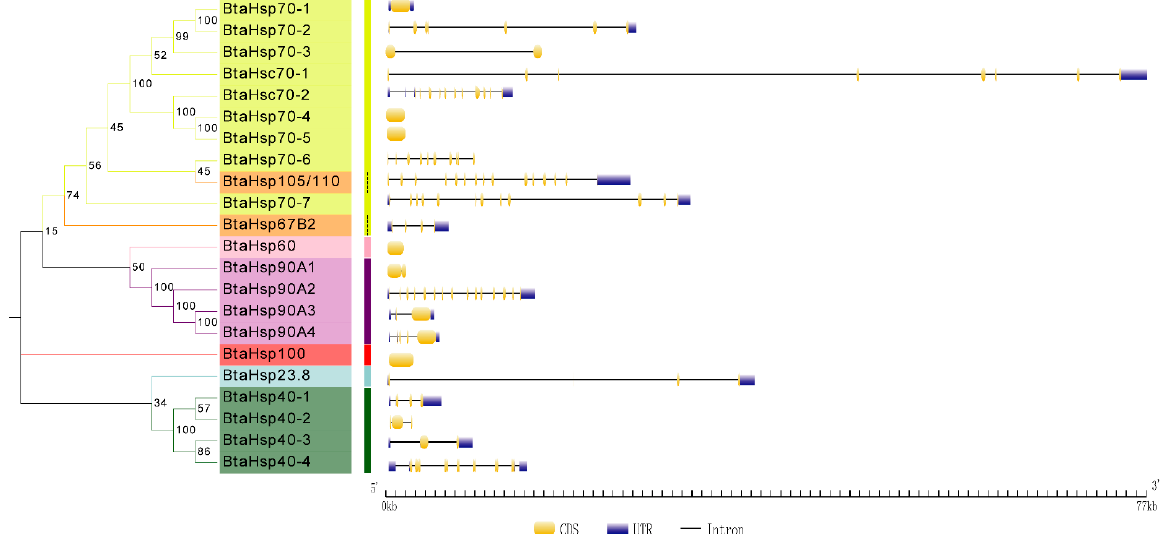
Figure 5. Phylogenetic relationships and gene structures analysis of the Bemisia tabaci HSP (BtaHSP) gene superfamily. The unrooted phylogenetic tree was constructed using MEGA7 by the neighbor- joining method and the bootstrap test was set as 1000 replicates. The colored shadow represents the different BtaHsp families. CDS/intron structures of BtaHSP genes. The yellow boxes, gray lines, and blue boxes, respectively, represent the cds, intron, and untranslated regions (UTR).